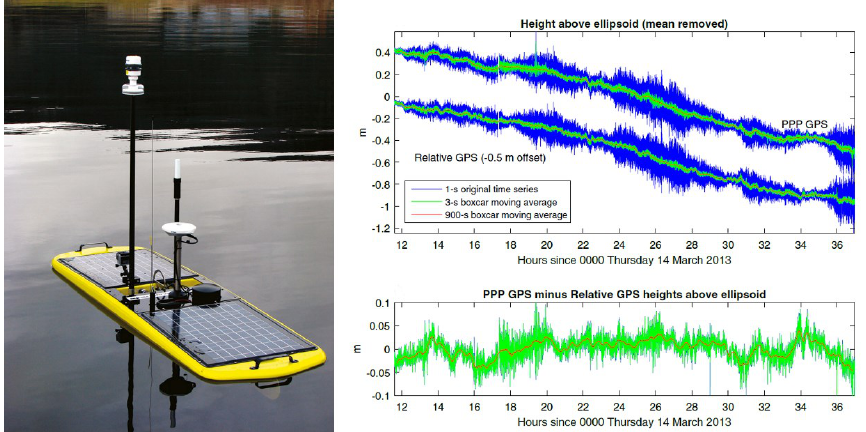
Figure 11. (Left) Wave glider with a Zephyr 2 GPS antenna and a meteorological mast. (Right) Time series of SSHs during the Loch Ness passage (PPR and relative GPS) and difference between the PPP and relative GPS curves [14].